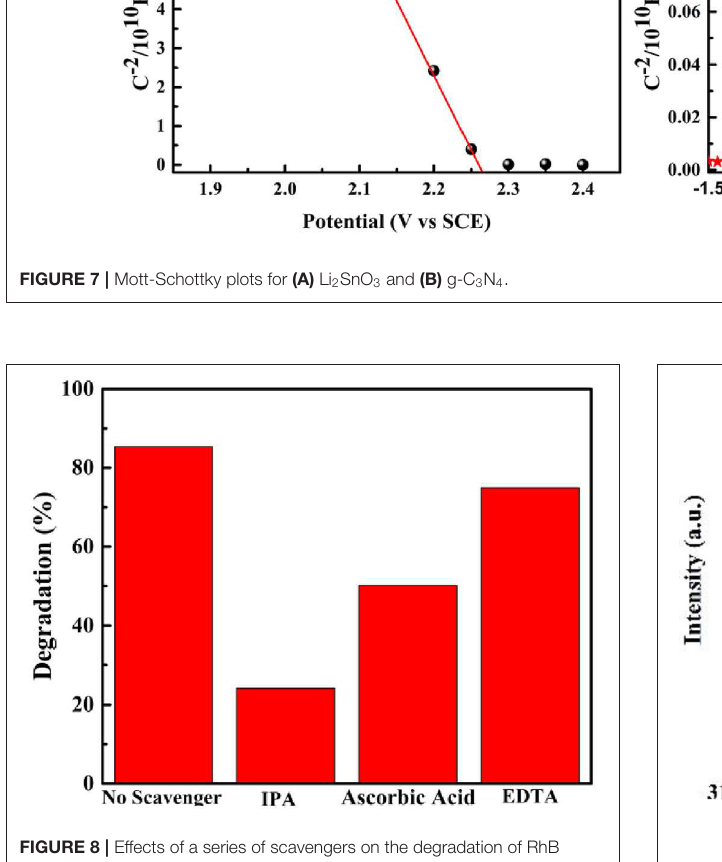
FIGURE 9 | DMPO spin-trapping EPR spectra for DMPO- · OH and DMPO- · O − 2 under visible light irradiation with heterojunction